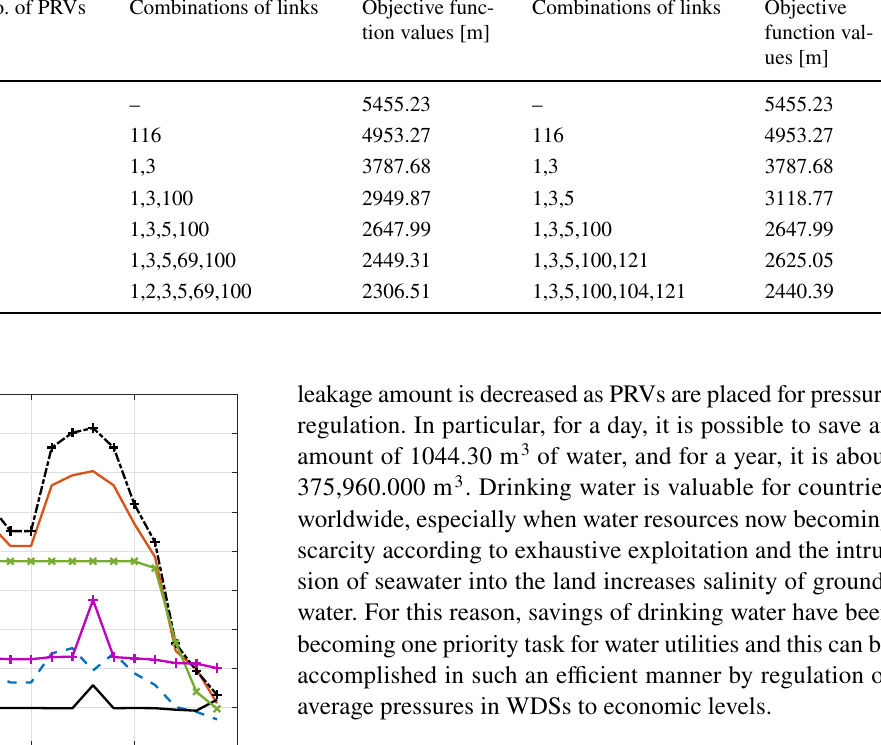
Table 6 Optimal PRV locations for the WDS